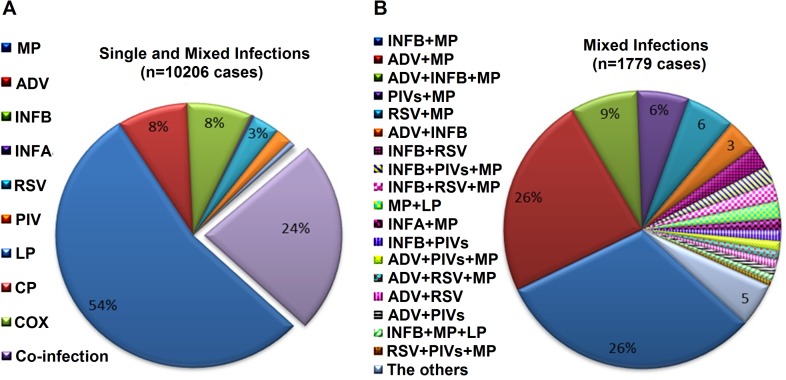
Prevalence of Respiratory Agents in Children with ARTIs.(A) The spectra of single and mixed infections of diverse pathogens in children with ARTIs in Wuhan, China (10,206 cases). (B) The spectrum of mixed infections of diverse pathogens in children with ARTIs in Wuhan (1,779 cases). Note: *Others, including CP+MP (9 cases), INFB+LP (9 cases), AdV+IBV+PIV (9 cases), AdV+IBV+RSV+MP (9 cases), MP+COX (8 cases), AdV+IAV+MP (8 cases), RSV+MP+LP (7 cases), and others (54 cases). Abbreviations: MP, M. pneumonia; INFB, influenza B virus; INFA, influenza A virus; AdV, adenoviruses; RSV, respiratory syncytial virus; PIV, parainfluenza virus; LP, L. pneumophila; CP, C. pneumonia; and COX, C. burnetii.